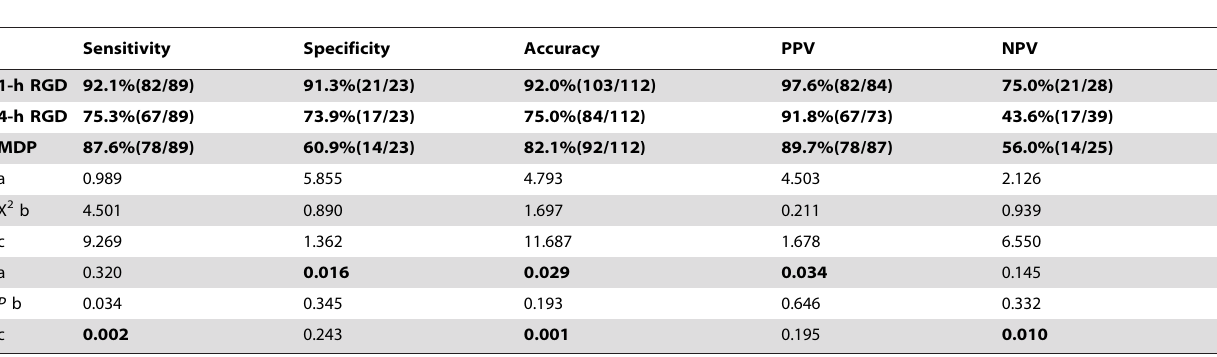
Table 3. Comparison of the diagnostic efficacy of 99m Tc-3PRGD2 integrin receptor imaging and 99m Tc-MDP bone scan for bone